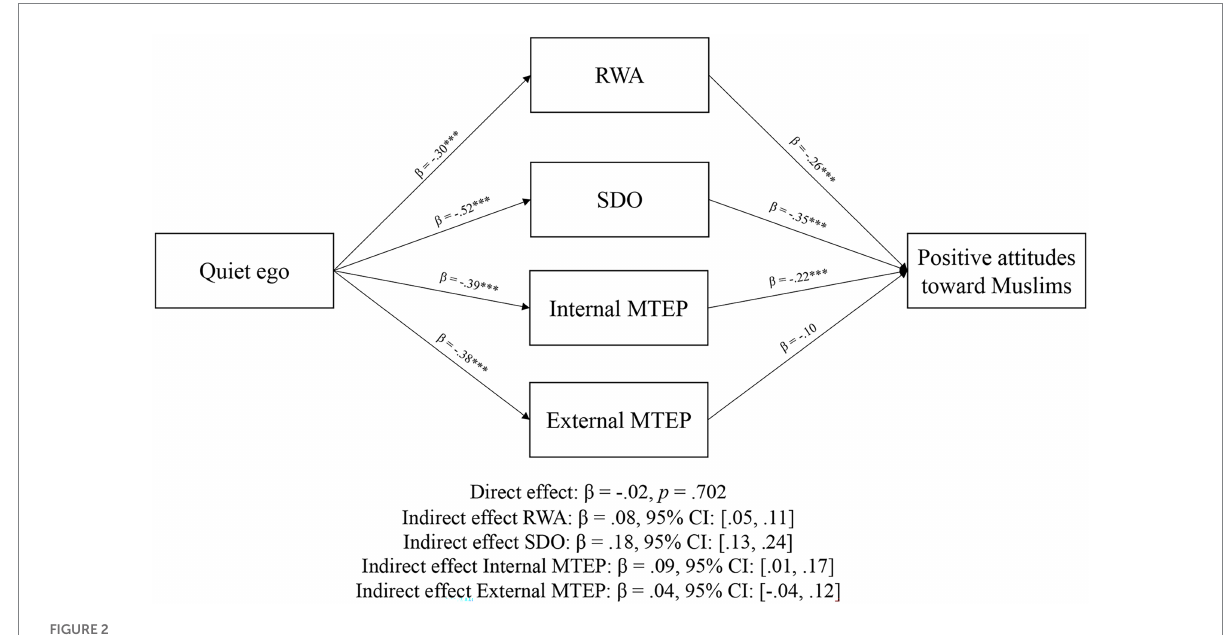
FIGURE 2 Mediation results from Study 2. *** p < 0.001.